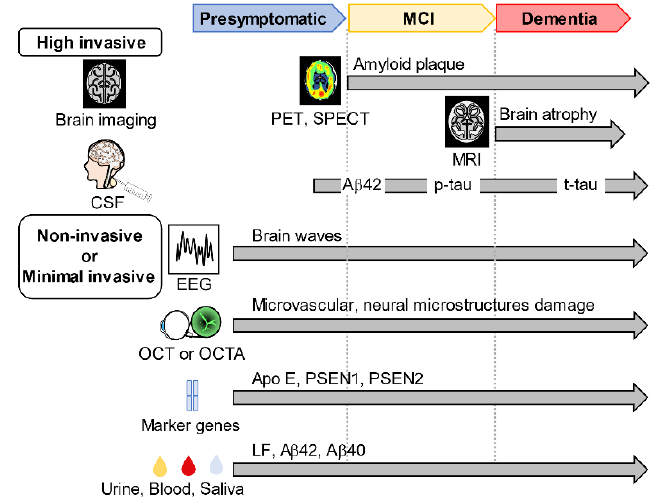
Figure 2. Biomarker-screening modalities for AD. Conventionally used biomarkers for Alzheimer’s disease (AD) include positron emission tomography (PET) and single-photon emission computed tomography (SPECT) to examine brain function and nuclear magnetic resonance to analyze structural changes in the brain. AD biomarkers include amyloid β 42 (Aβ42), phosphorylated tau (p-tau), and total tau (t-tau) levels in cerebrospinal fluid. New biomarkers such as optical coherence tomography (OCT) and optical coherence tomography angiography (OCTA) for measuring eye vascular abnormalities, electroencephalograms (EEG) for measuring brain waves, and AD marker genes have been found. Biomarkers in urine, blood, and saliva have also been identified.